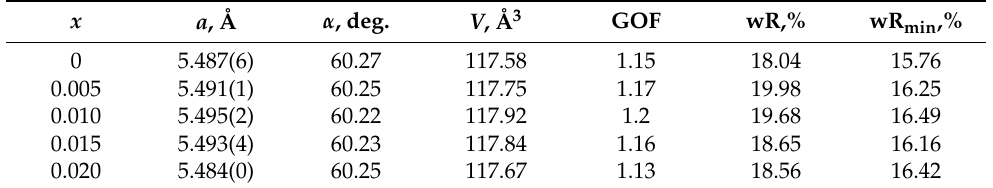
Table 1. Structural parameters of La 0.5 − x Sr 0.5 FeO 3 − δ refined in Rhombohedral setting of R 3 C S.G.